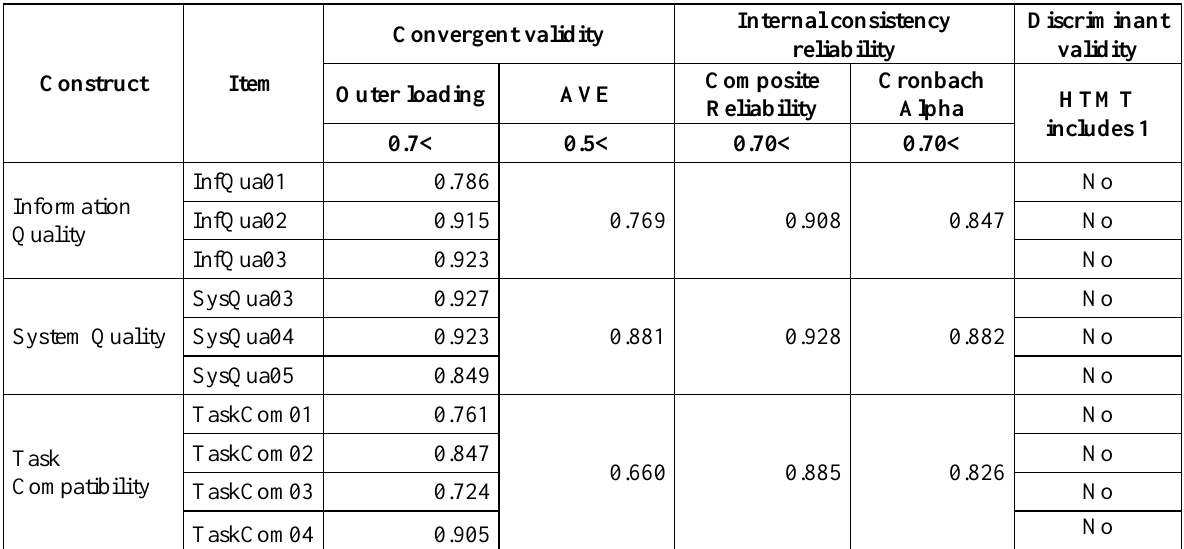
Table 2. Assessment of reflective measurement model